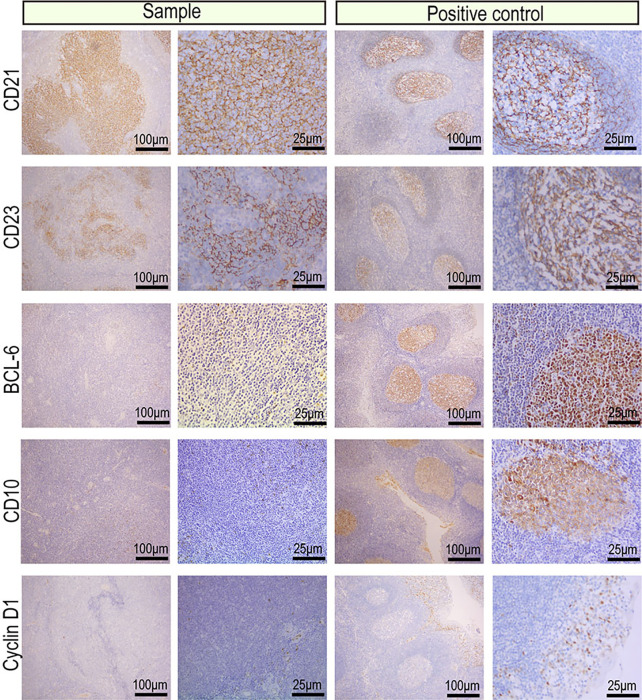
IHC images of the indicators for differential diagnosis of primary renal MALT lymphoma and other blood system tumors. Representative IHC images for CD21 and CD23 showed an irregular and damaged follicular dendritic network which was related to lymphoma. A negative representative for markers of germinal center lymphocyte, BCL-6 and CD10 may help differentiate from follicular lymphoma. Moreover, a negative representative of CyclinD1 may distinguish between mantle cell lymphoma or partial plasmablastic lymphoma and primary renal MALT lymphoma.